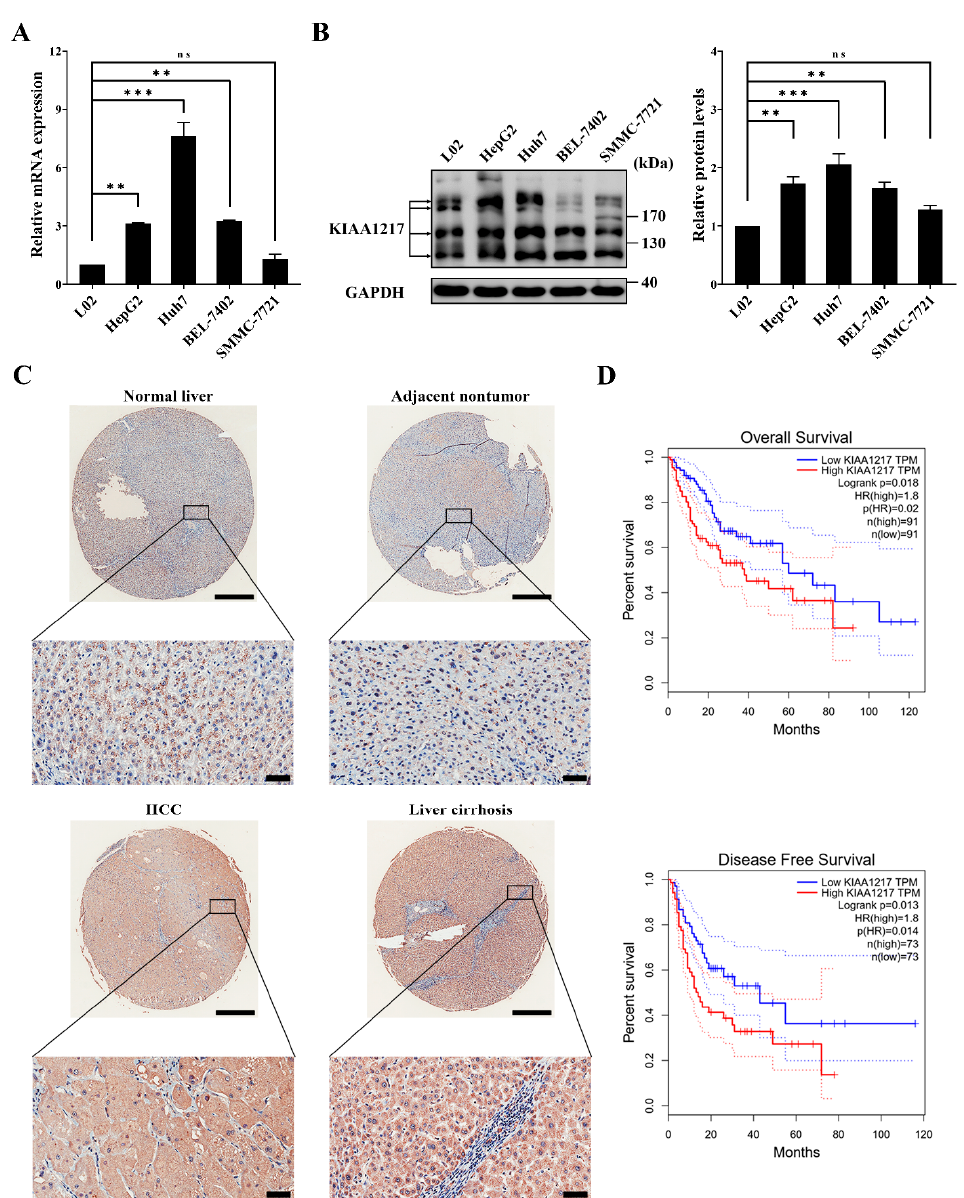
Figure 1. Upregulation of KIAA1217 was frequently observed in HCC samples and indicated shorter survival. ( A ) RT–qPCR analysis of KIAA1217 mRNA expression in HCC cell lines. β -Actin was used as an internal control. ( B ) Left panel, Western blot analysis of KIAA1217 protein expression in HCC cell lines; right panel, quantitative evaluation of the Western blot results. GAPDH served as a loading control. ( C ) Representative images of IHC staining for KIAA1217 expression in normal liver tissue and matched adjacent nontumor tissue, HCC tissue, and cirrhotic liver tissue. Magnification, × 20 (upper panel) and × 200 (lower panel); scale bars: 500 µ m (upper panel) and 50 µ m (lower panel). ( D ) Kaplan–Meier analysis of the correlation between KIAA1217 expression and the overall survival or disease-free survival of patients with HCC using the GEPIA web server [25]. ns, not significant; ** p < 0.01; *** p < 0.001. Error bars: